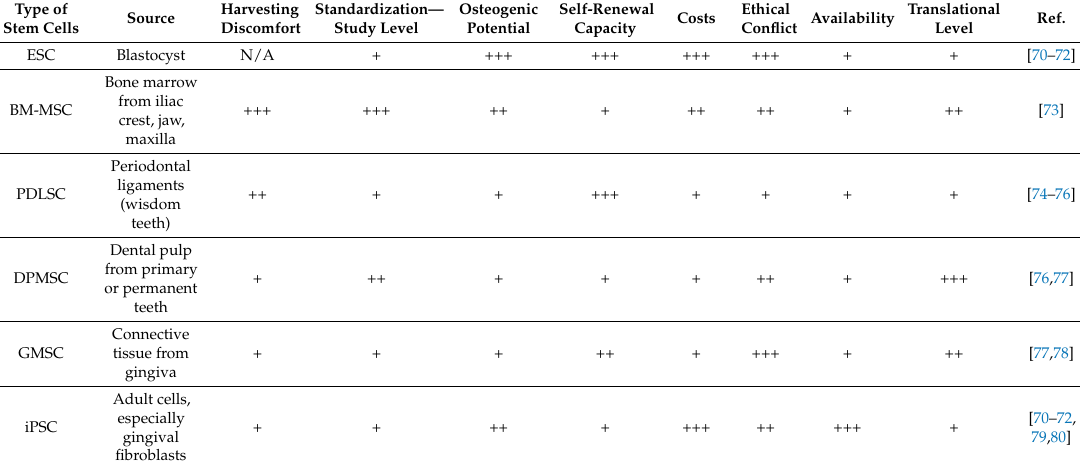
Table 1. Characteristics of different types of stem cells used for regenerative